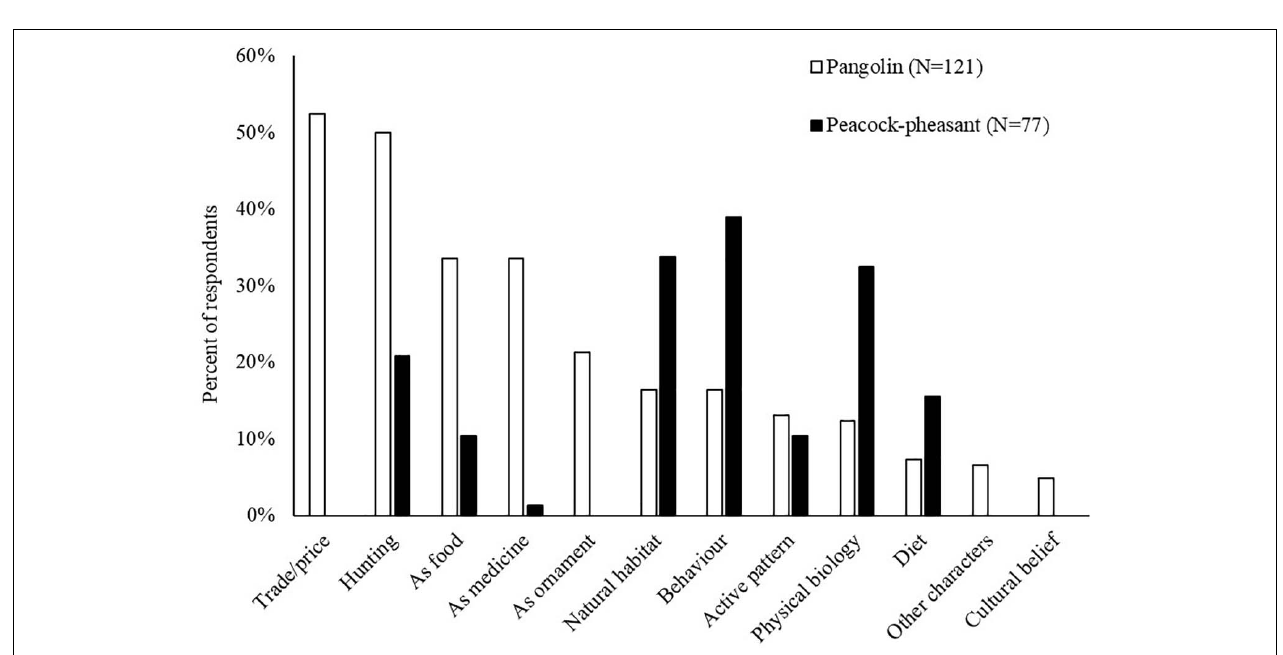
FIGURE 3 | Percentage of interviewees providing different categories of knowledge about pangolins and peacock-pheasants. Note that respondents may provide knowledge on more than one category.